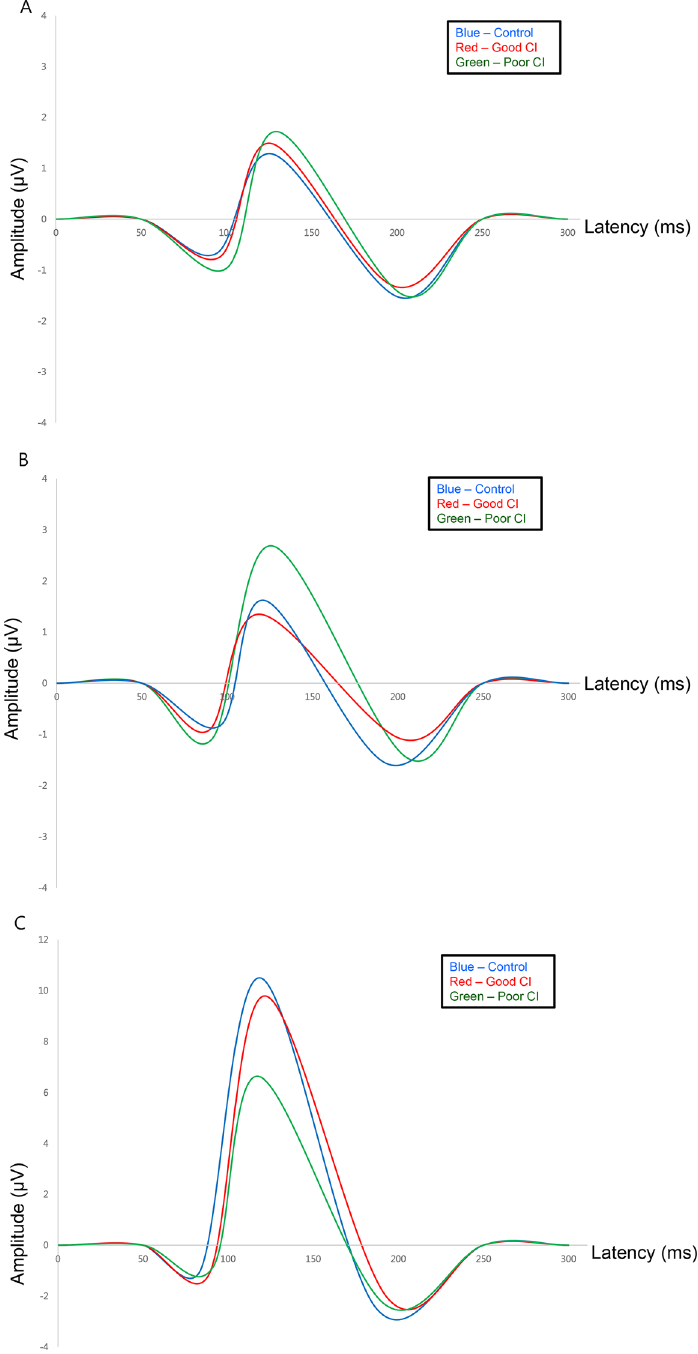
Fig 3. Average waveforms of VEP from three different groups in study population. Average waveforms over each cortex indicated different patterns according to groups. Blue line represented the waveforms of normal control. Red and green line represented good CI performers and poor CI performers, respectively. (A) Average waveforms over the left temporal cortex. There was no significant difference in amplitudes or latencies among the three groups. (B) Average waveforms over the right temporal cortex. Poor CI group (green) showed larger P1 amplitude compared to the control and good CI performer group. (C) Average waveforms over the occipital cortex in normal control and good CI performer group showed larger P1 amplitude compared to the poor CI performer group.